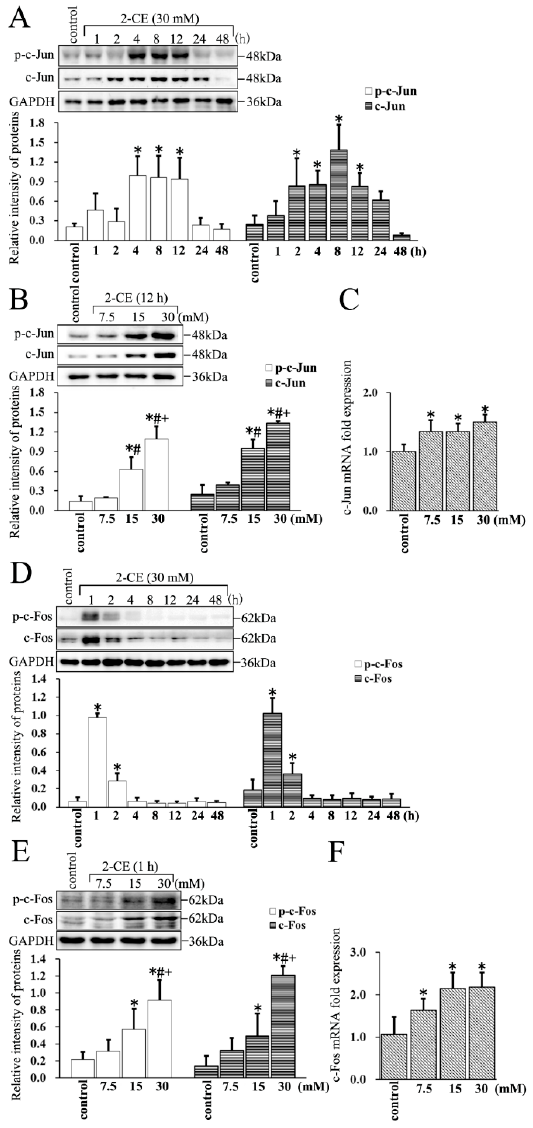
Figure 4. The expression and phosphorylation of c-Jun and c-Fos in astrocytes induced by 2-CE. ( A , D ) Astrocytes were treated with 30 mM 2-CE for the indicated times, and ( B , C , E , F ) with 0, 7.5, 15, and 30 mM 2-CE for 12 h; ( A , B , D , E ) Levels of p-c-Jun, p-c-Fos, c-Jun, and c-Fos in astrocytes measured by Western blotting; ( C , F ) The c-Jun and c-Fos mRNA levels analyzed by RT-PCR. ( n = 4; mean ± SD; * p < 0.05 vs. control group, # p < 0.05 vs. 7.5 mM of 2-CE, + p < 0.05 vs. 15 mM of 2-CE; one-way ANOVA followed by SNK